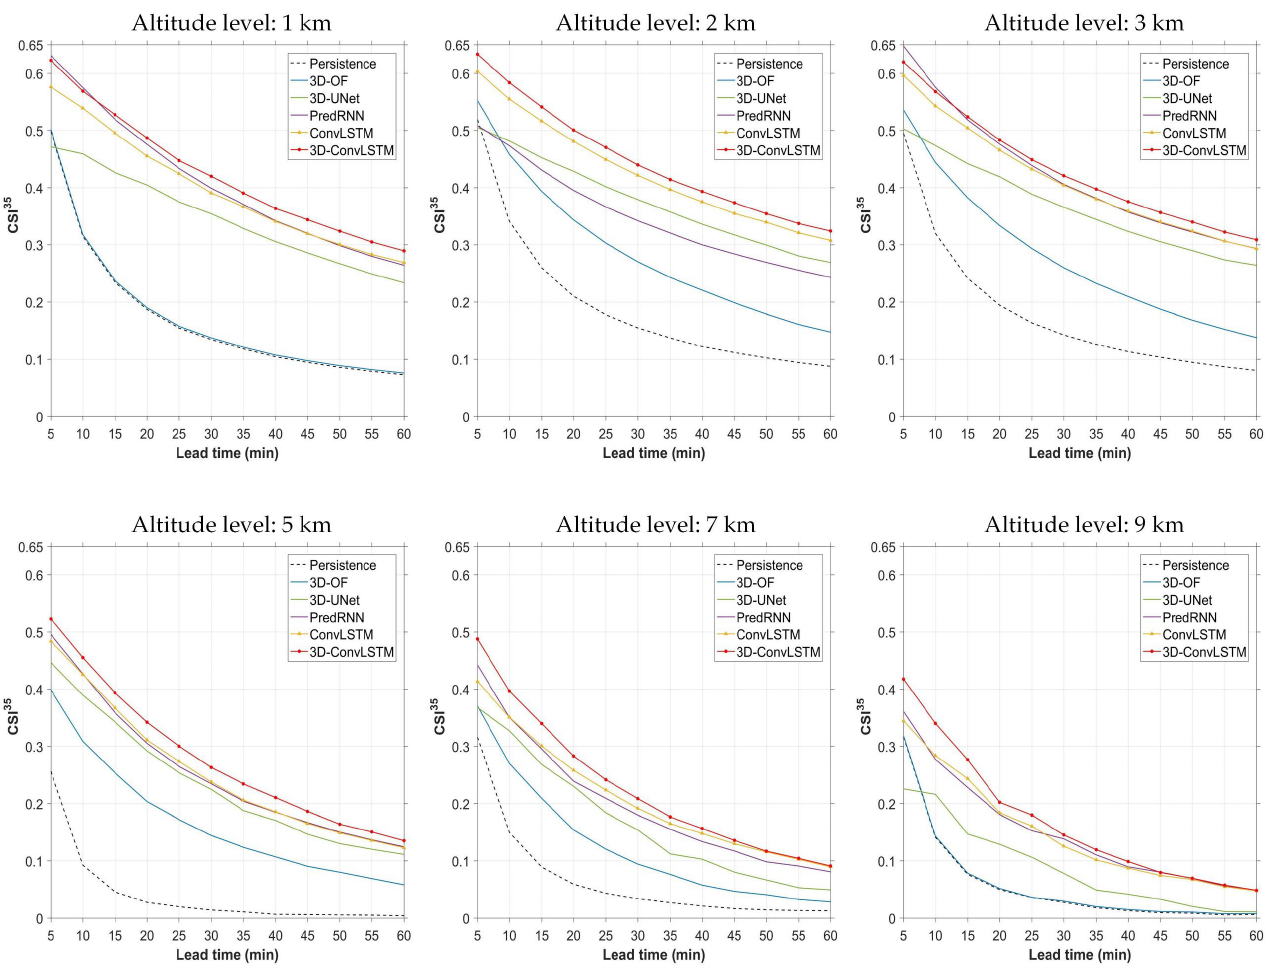
Figure 5. CSI curves of the compared 3D REE models at 35 dBZ for six different altitude levels (1, 2, 3, 5, 7, and 9 km). Table 7. Reflectivity statistics in the test set.